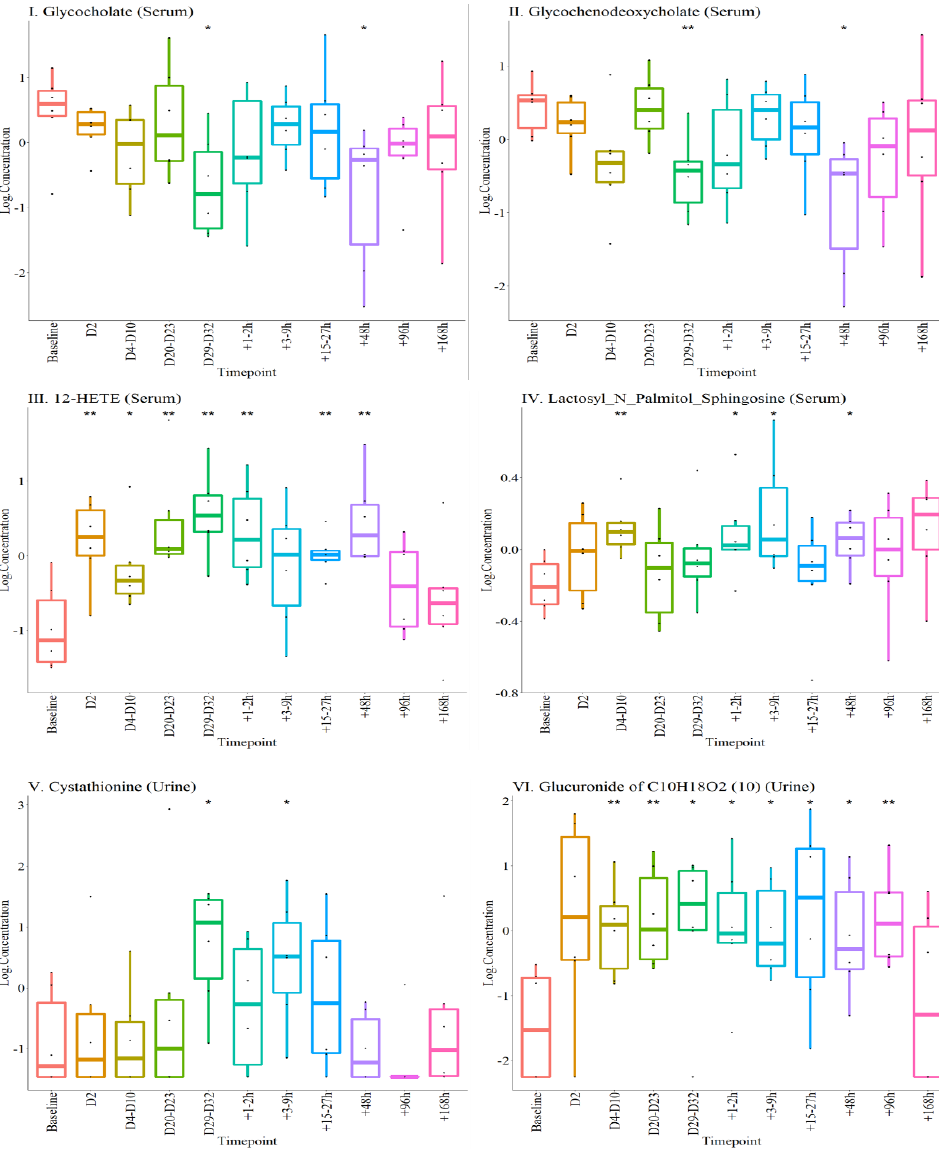
Figure 6. Concentrations of eight metabolites (four in serum and four in urine) altered at different time points before day 7 post-transfusion. The log concentrations at different time-points are plotted for each metabolite as labelled in I to VII1. * p < 0.05, ** p < 0.01, compared with baseline. 2.4.2. Selected Metabolite Panel The remaining nine metabolites (seven serum and two urinary) were significantly altered up to Day 7 (+168 h) post-transfusion. Of these, three serum metabolites (gly- coursodeoxycholate, downregulated; guanosine and inosine, upregulated) were signifi- cantly altered both post-donation and post-transfusion, compared to baseline (Figure 7I – III). The other four serum metabolites in this panel (S-allcysteine, 17-alphahydroxypreg- nenalone 3, Glutamine conjugate of C 6 H 10 O 2 (2)* and Sphinganine) were only altered post- transfusion (Figure 7IV – VII).